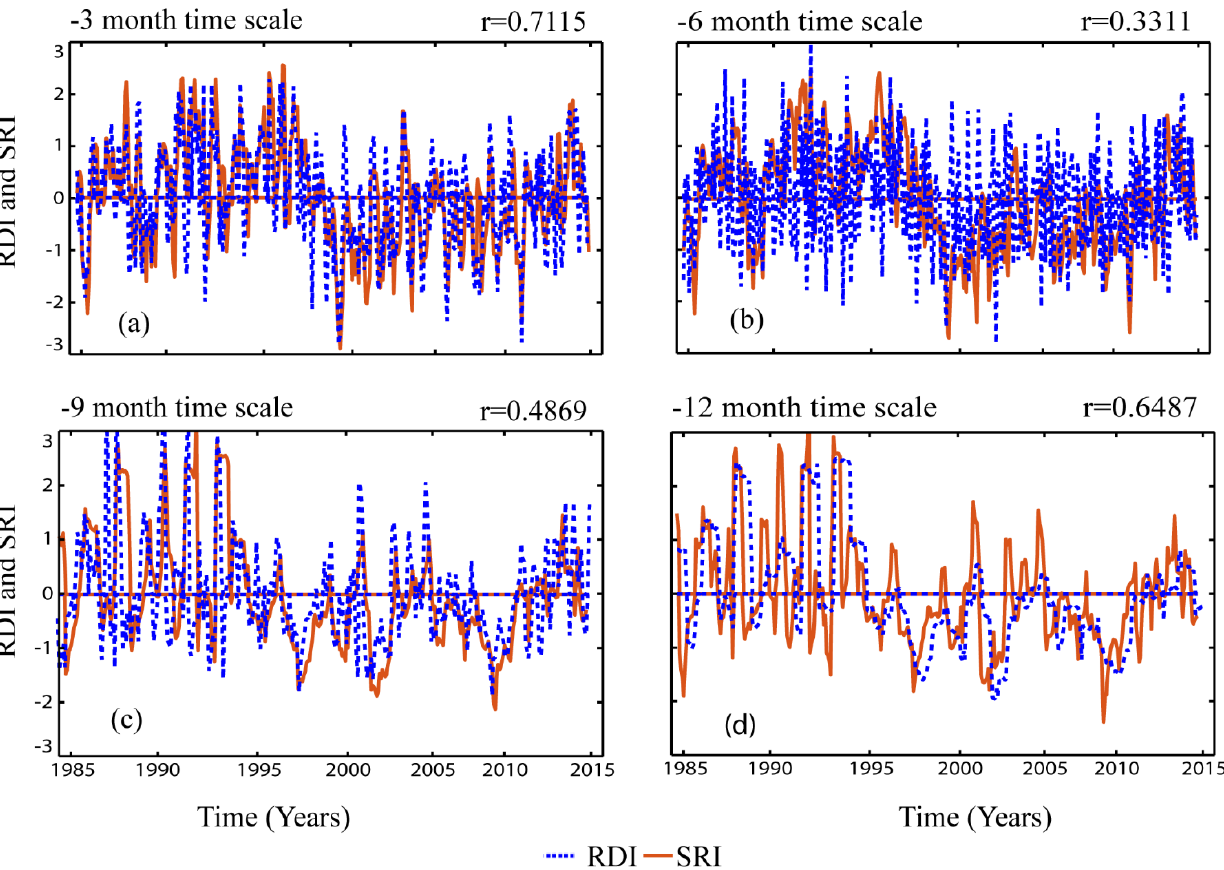
Figure 6. Average RDI and SRI values from hydrometeorological stations for various reference time scales (3, 6, 9, and 12 months). ( a ) RDI-3 and SRI-3 series; ( b ) RDI-6 and SRI-6 series; ( c ) RDI-9 and SRI-9 series; and ( d ) RDI-12 and SRI-12 series.